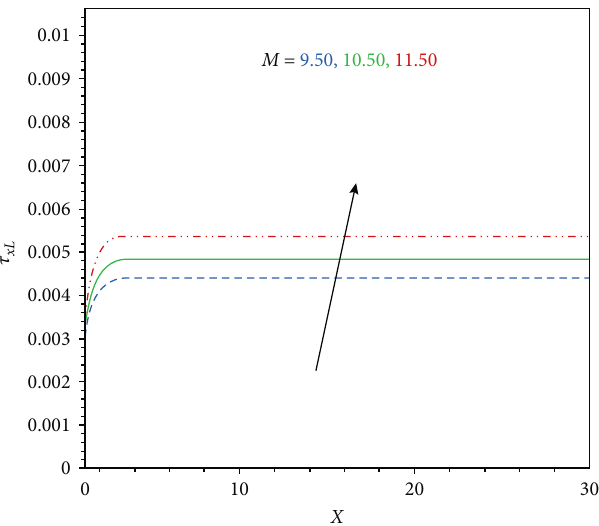
Figure 4: Validations of steady state for magnetic fi eld on shear stress at Y = 0 : 3 , Y = 0 : 5 , Y = 1 : 5 , and Y = 2 : 5 . Table 1: Validations of steady state for magnetic fi eld on shear stress for Figure 4 at Y = 0 : 3 , Y = 0 : 5 , Y = 1 : 5 , and Y = 2 : 5 . Average skin